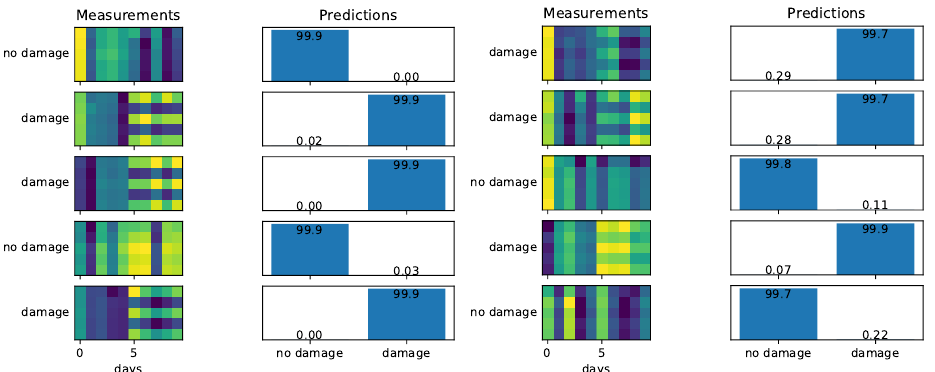
Figure 10. Performance of the proposed neural network using the first five natural modes. On the left ,the degradation coefficient is 0.5 (easy case), and on the right, the degradation coefficient is 0.8 (hard